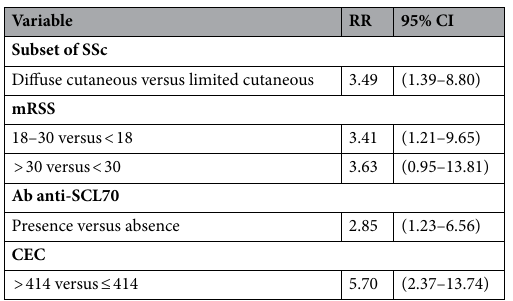
Table 2. Relative risk (RR) and corresponding 95% Confidence intervals for the significant association between patient characteristics and disease